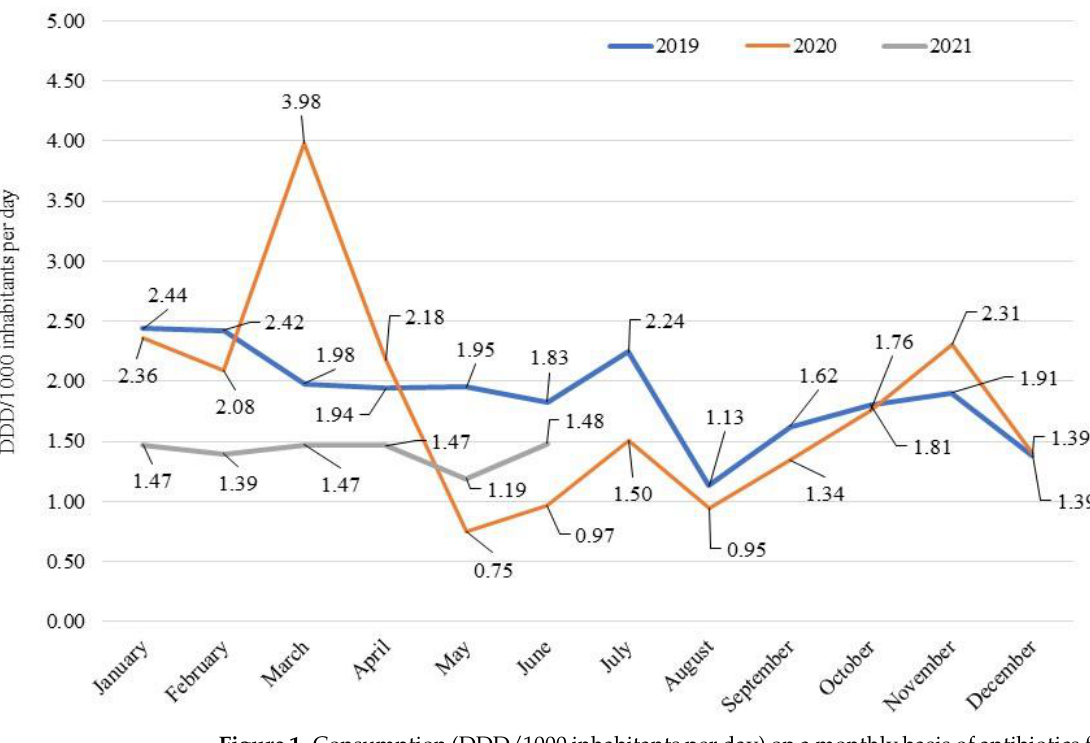
Figure 1. Consumption (DDD/1000 inhabitants per day) on a monthly basis of antibiotics for sys- temic use (J01) in the hospital setting: 2019 – 2021